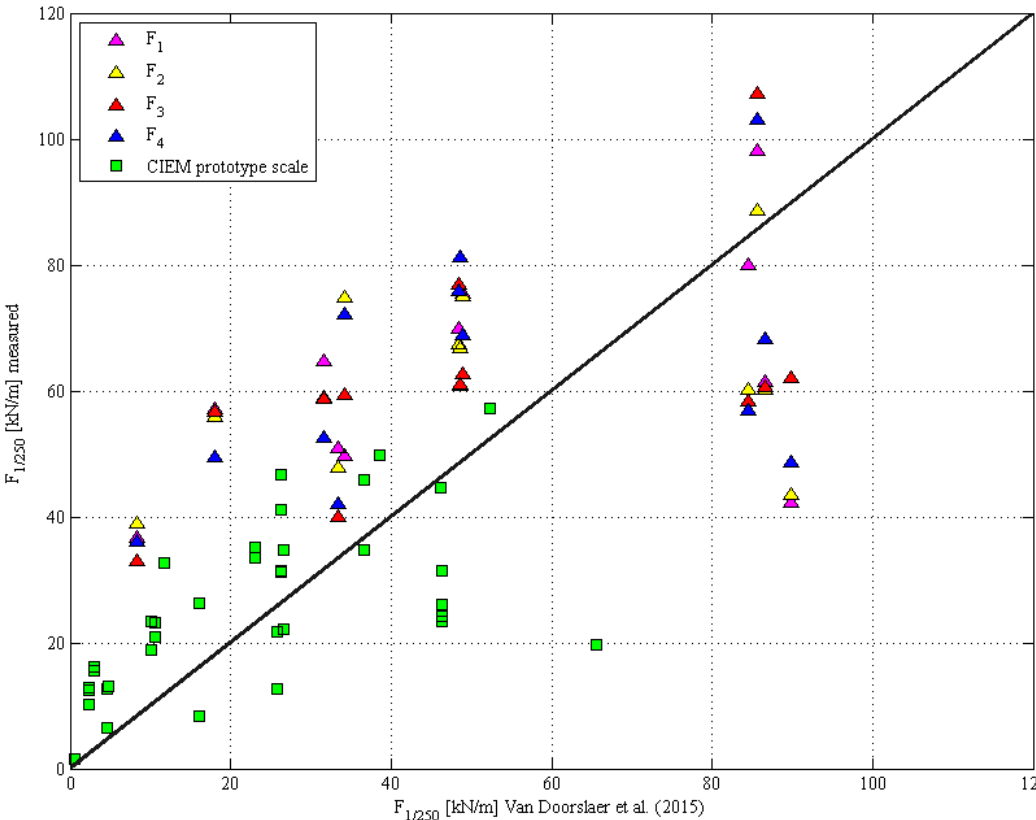
Figure 19. Dependence of the non-dimensional wave forces on the relative freeboard and comparison with data from UPC [10] .